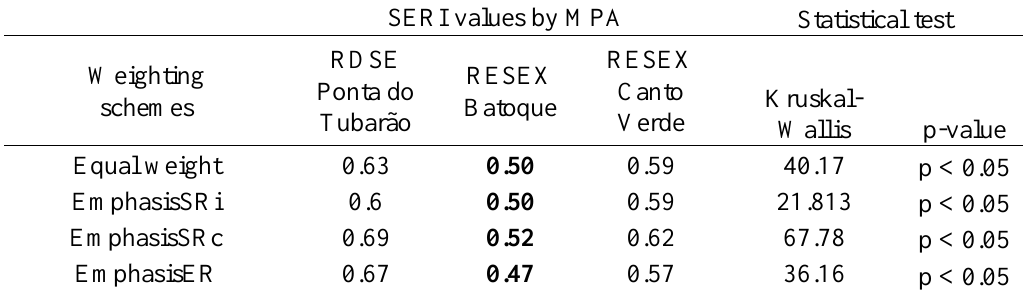
Table A6.2: The SERI average values for the four weighting schemes in the three marine protected areas (MPAs) analyzed: RDSE Ponta do Tubarão, RESEX Batoque, and RESEX Canto Verde. The last two columns show the results of the Kruskal-Wallis statistical test. SERI = Social-Ecological Resilience Index. SRi = Social resilience at the individual level; SRc = Social resilience at the community level; ER = Ecological resilience; SERI = Social-Ecological Resilience Index. The least resilient reserve in each weighting scheme is highlighted in